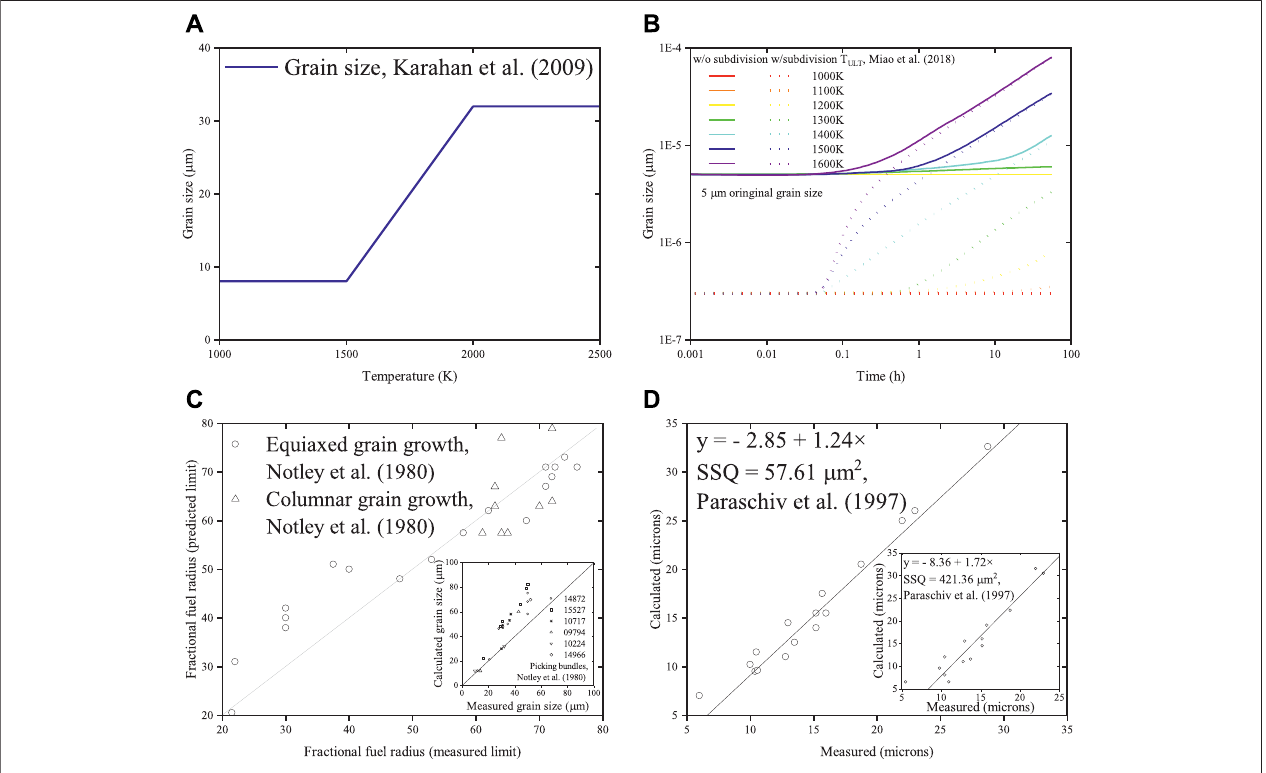
FIGURE 4 | (A) Grain size with temperature in the metallic fuel. (B) Grain size with time in U 3 Si 2 . (C) Predicted fuel radius to fractional fuel radius in UO 2 . (D) Calculated vs. measured swelling in UO 2 (Notley et al., 1980; Paraschiv et al., 1997; Karahan et al., 2009; Miao et al.,